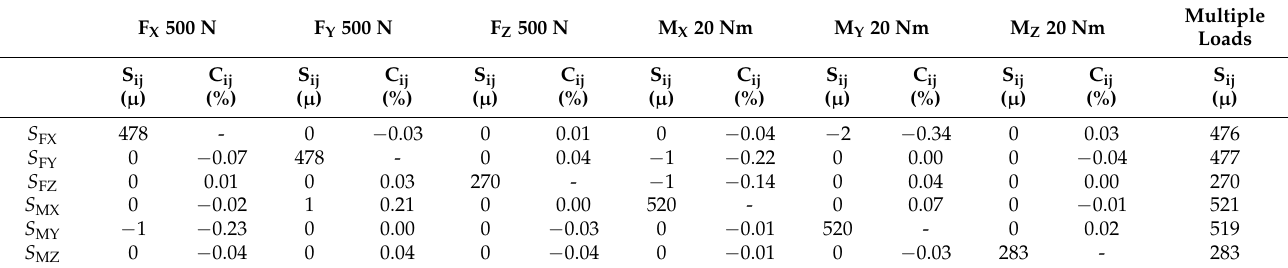
Table 5. Crosstalk from finite element analysis of 24 strain gage arrangement.